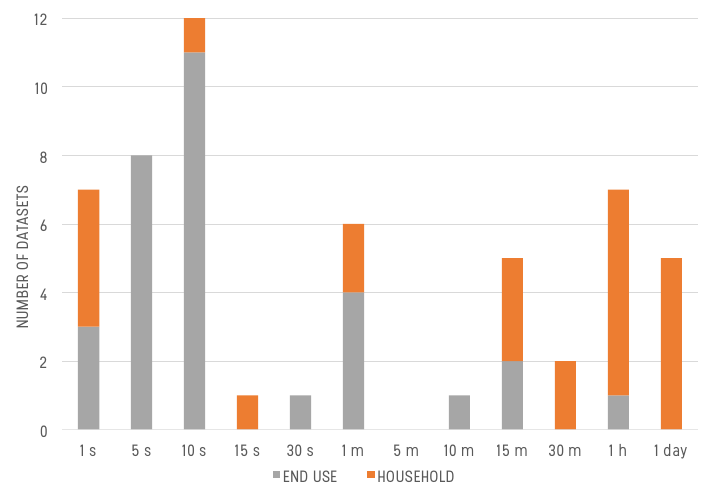
Figure 5. Dataset count for different time sampling frequencies. Only the reviewed datasets gathered at the household (gray) and end use scale (orange) are